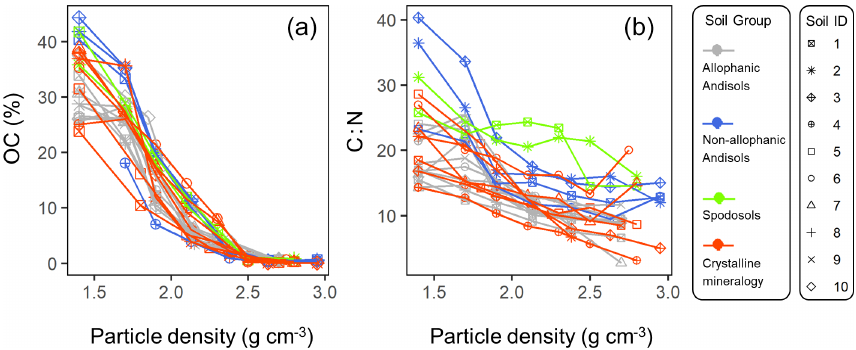
Figure A3. Line graphs showing organic C concentration per fraction, as weight % (a) and C:N ratio (b) against soil particle density. Each line represents each soil sample which belongs to one of the four soil groups. Soil ID numbers, shown in different symbol shapes, correspond to Table 1.